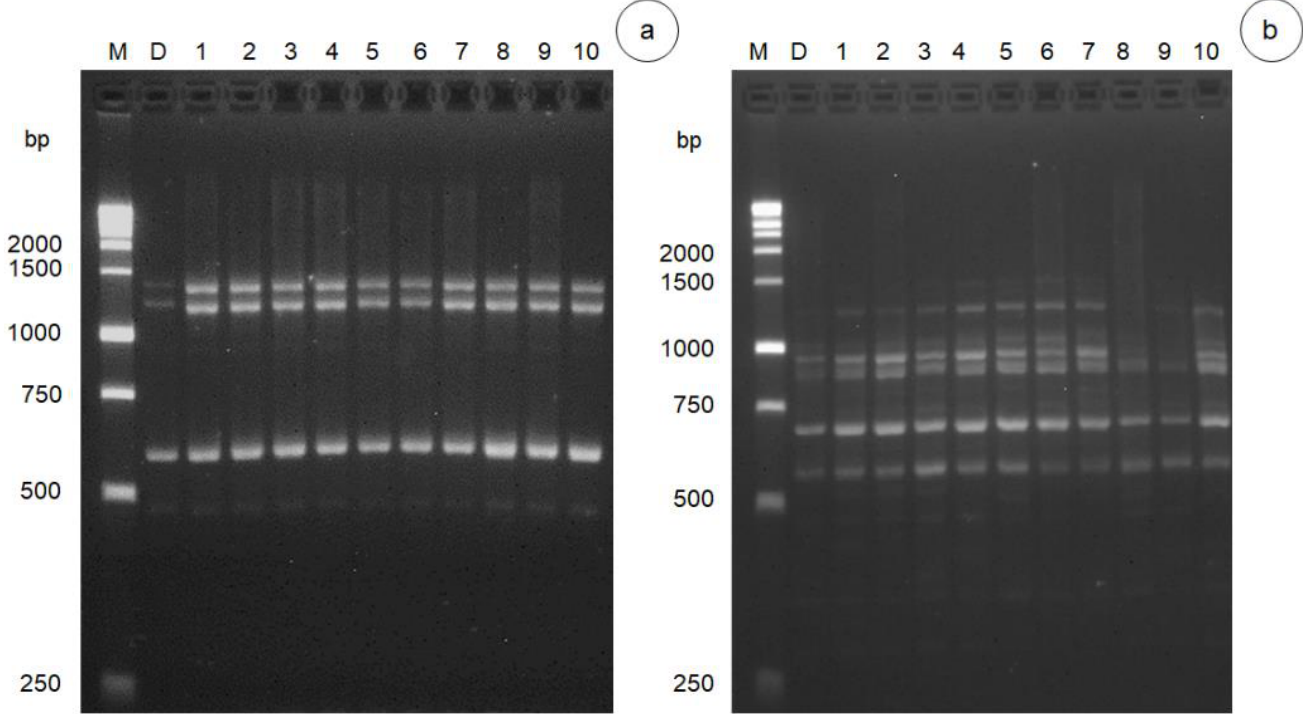
Figure 3. Electrophoresis pattern with ISSR markers of ten individuals (1–10) of vanilla ( Vanilla planifolia Jacks. ex Andrews) exposed to gamma radiation with respect to donor plant (D). ( a ) Dose 60 Gy, primer UBC-812 ( b ) dose 20 Gy, primer UBC-840. M = molecular weight marker and bp = base